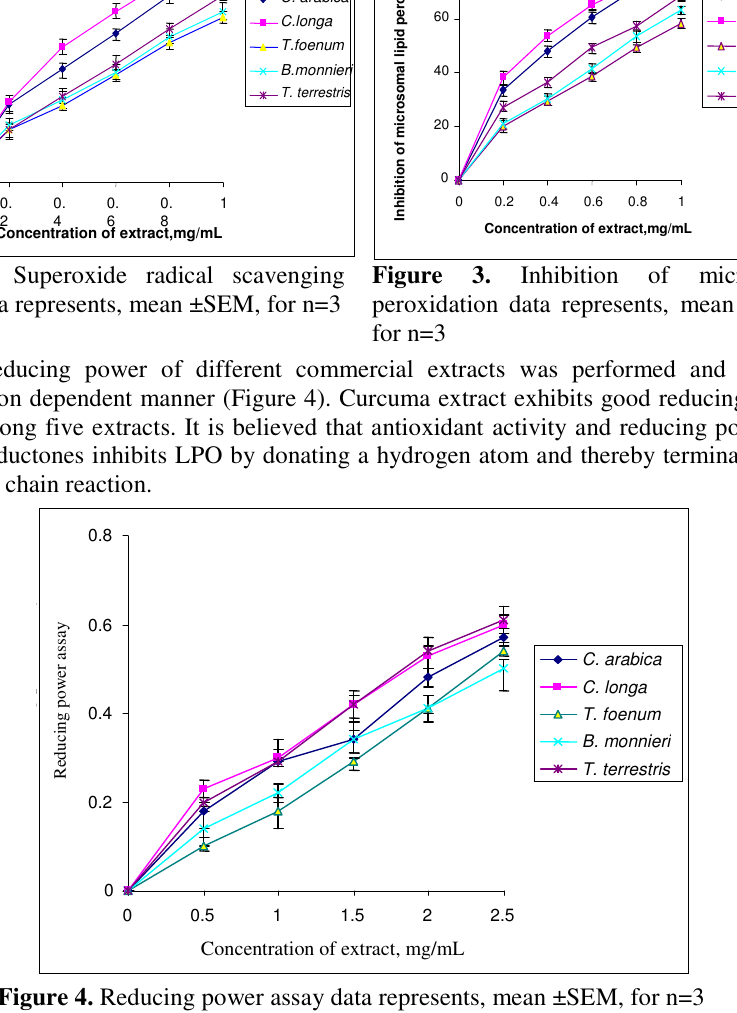
Figure 4. Reducing power assay data represents, mean ±SEM, for